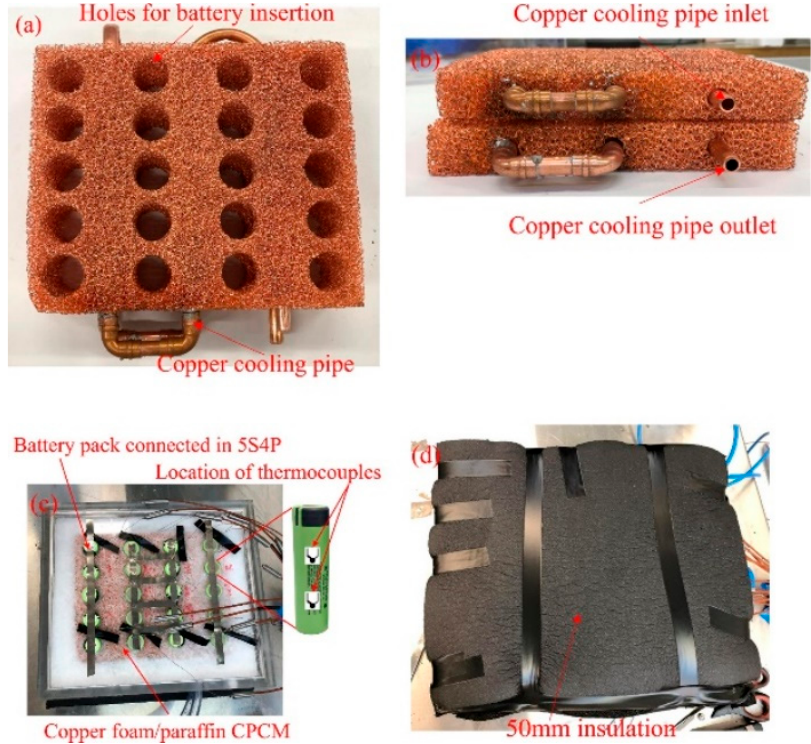
Figure 21. The hybrid active-passive BTMS described in [74]. ( a ) the Cu MF and the cooling pipes embedded into it—top view; ( b ) same as ( a ), front view; ( c ) PCM-impregnated Cu foam; ( d ) BTMS with insulation applied.